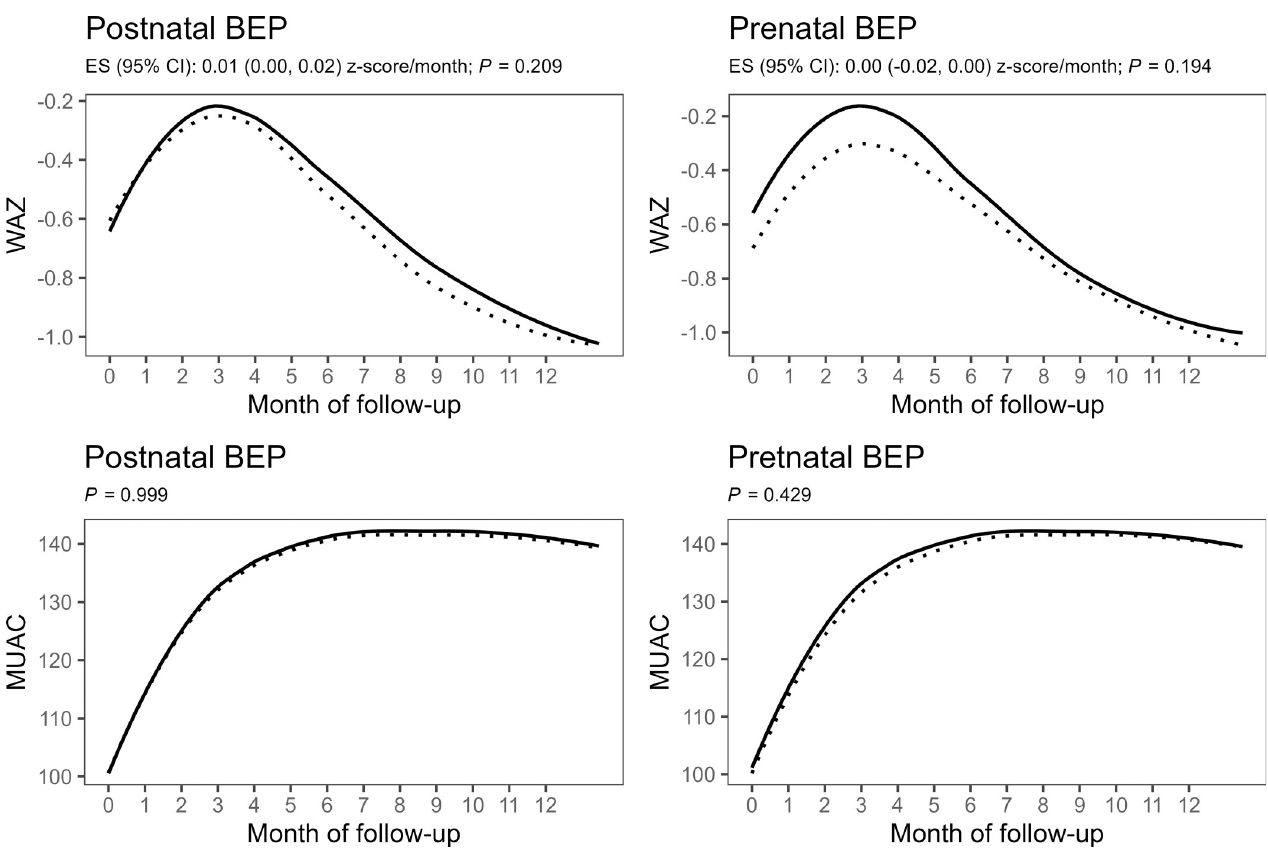
Fig 3. Monthly changes in WAZ (upper panels) and MUAC (lower panels) by postnatal (left panels) and prenatal (right panels) intervention arms with the dashed lines representing the control group (IFA) and solid lines representing the intervention group (IFA + BEP). Line graphs represent locally weighted scatterplot smoothing of observed values. Group differences were estimated using mixed-effects models with random intercepts for infant and random slopes for intervention time, with fixed effects including time (for WAZ), time spline variables with 6 knots (for MUAC), intervention group, and time × group interaction adjusted for allocation to the other intervention, clustering indicators (health center and randomization block), and a priori determined prognostic factors (maternal height, BMI, MUAC, hemoglobin, age and gestational age at inclusion, and parity). For the spline model of MUAC, group difference was tested by likelihood ratio test comparing a model with and without time × group interaction terms. BEP, balanced energy–protein supplement; BMI, body mass index; CI, confidence interval; ES, regression coefficient; IFA, iron–folic acid; MUAC, mid-upper arm circumference; WAZ, weight-for-age